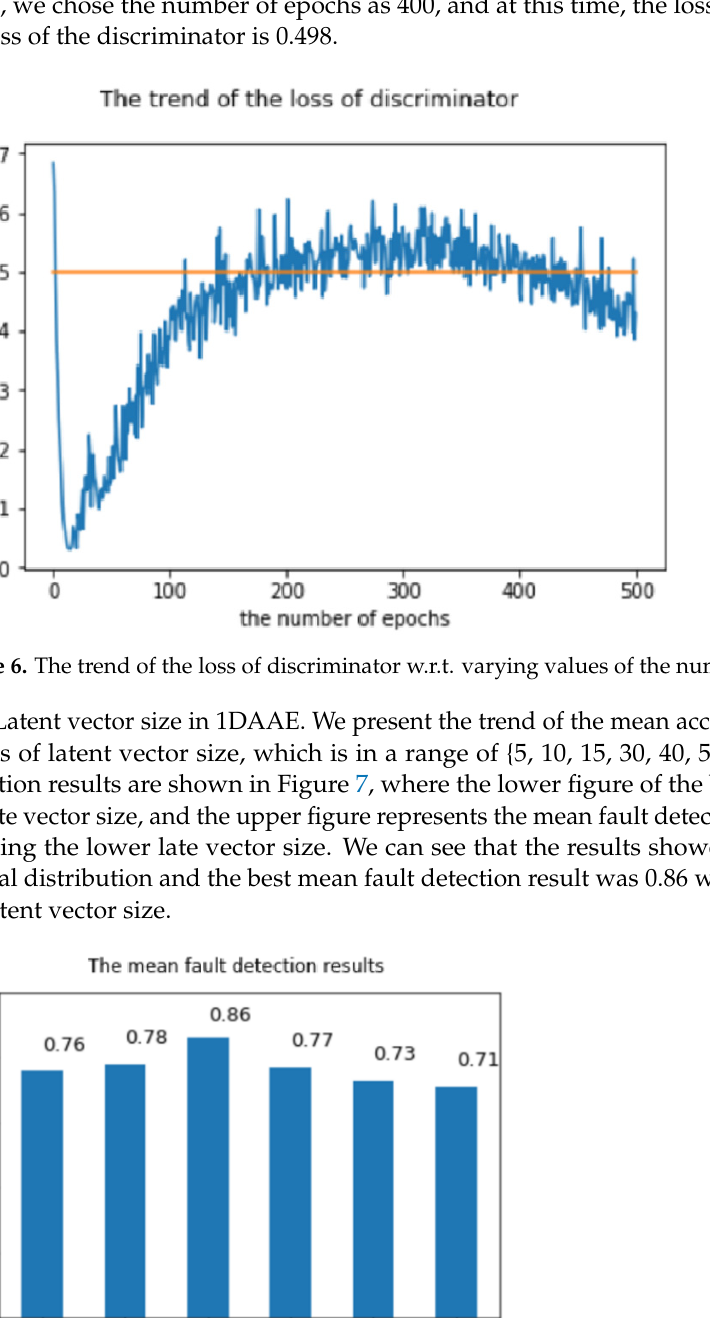
Figure 5. The trend of the loss of AE w.r.t. varying values of the number of epochs.